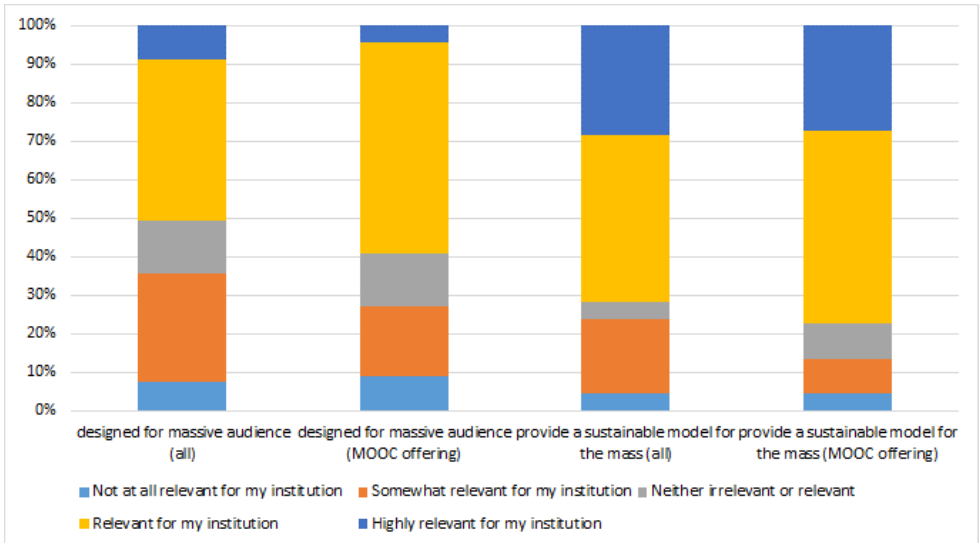
Figure 9. Importance of the massive dimension of